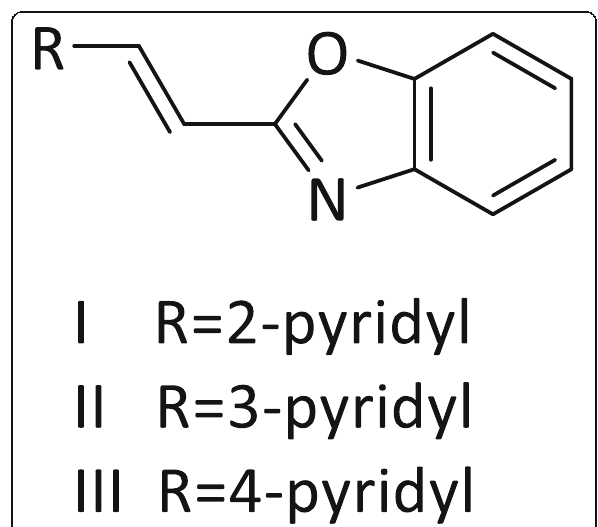
Fig. 39 Benzoxazole-pyridine